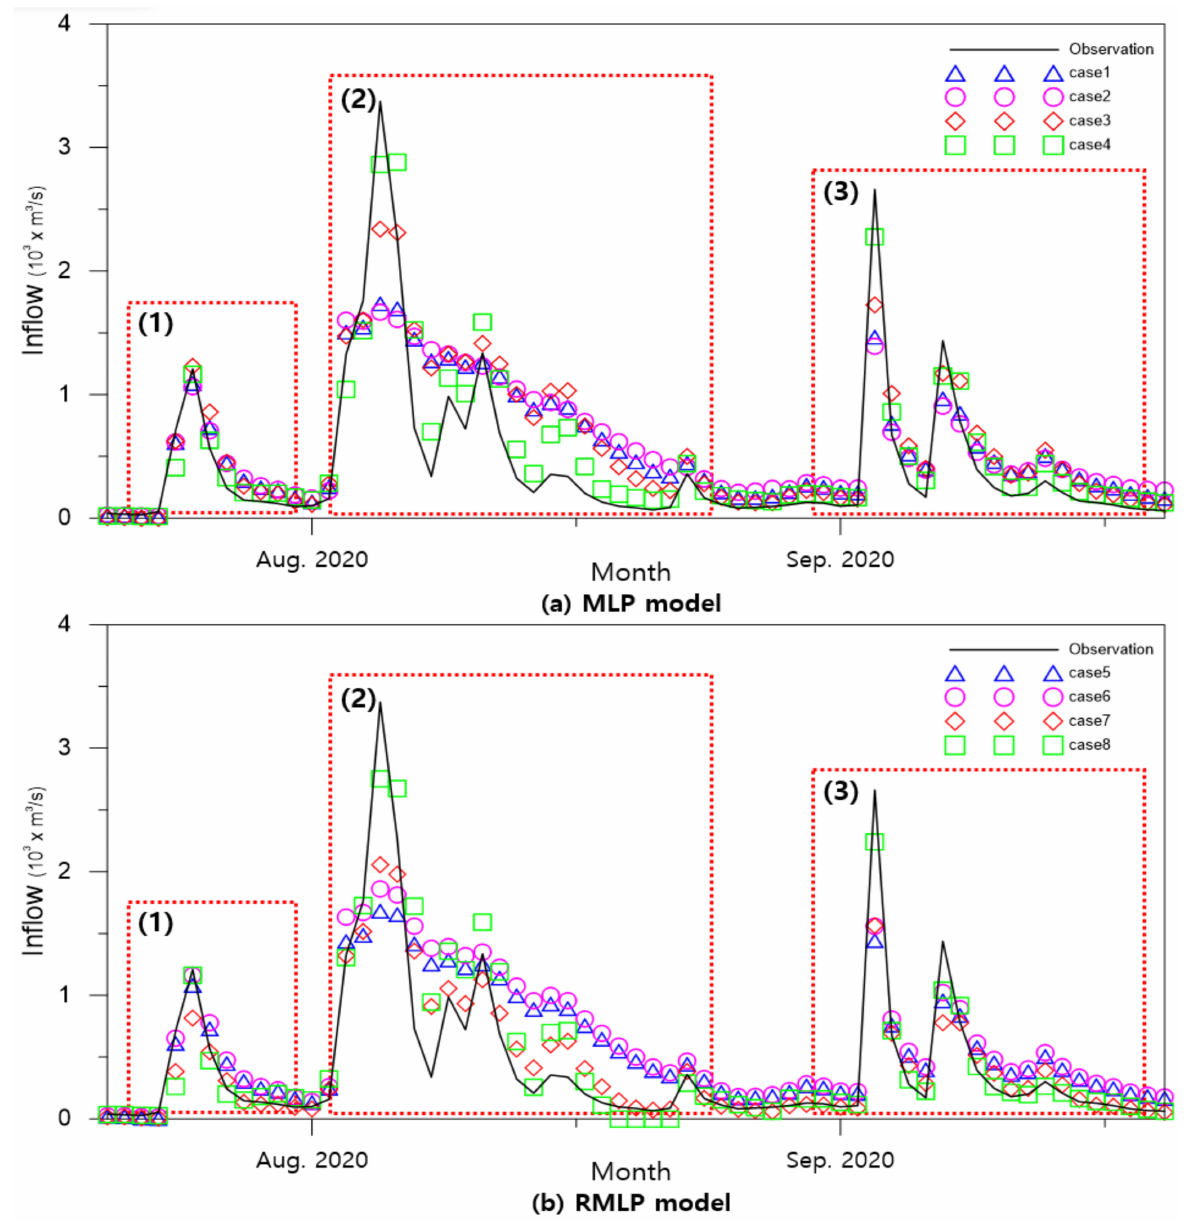
Figure 9. Inflow prediction results of the MLP (Cases 1–4) and RMLP (Cases 5–8) models. The black line means observed discharge, and the blue triangle indicates predicted discharge with the original data, the purple circle is the seasonal division, the red diamond is the normalization, and the green square is the result when all preprocessing was